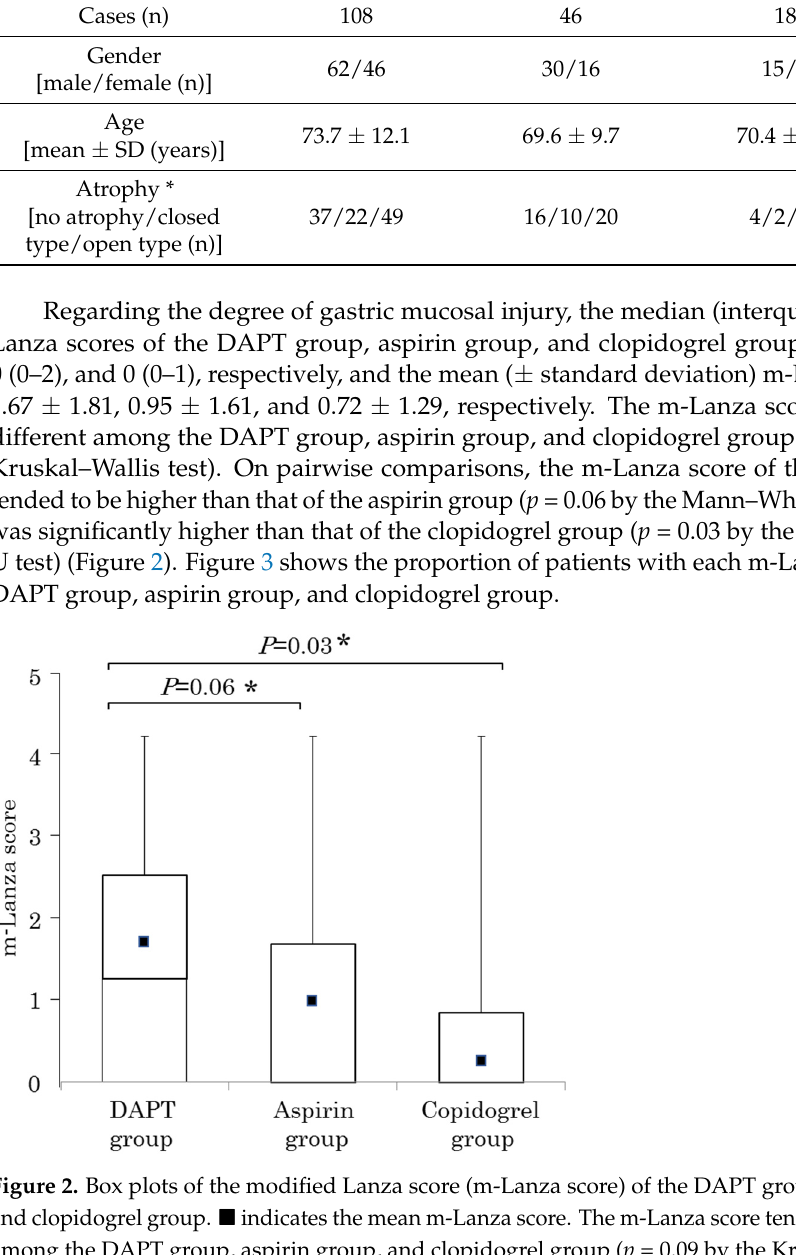
Table 1. Characteristics of the eligible patients. * Gastric mucosal atrophy was evaluated in the endoscopic images according to the Kimura–Takemoto classification, and was classified by degree into two grades of closed type and open type. DAPT, dual antiplatelet therapy; SD, standard deviation. Aspirin Group Clopidogrel Group DAPT Group P